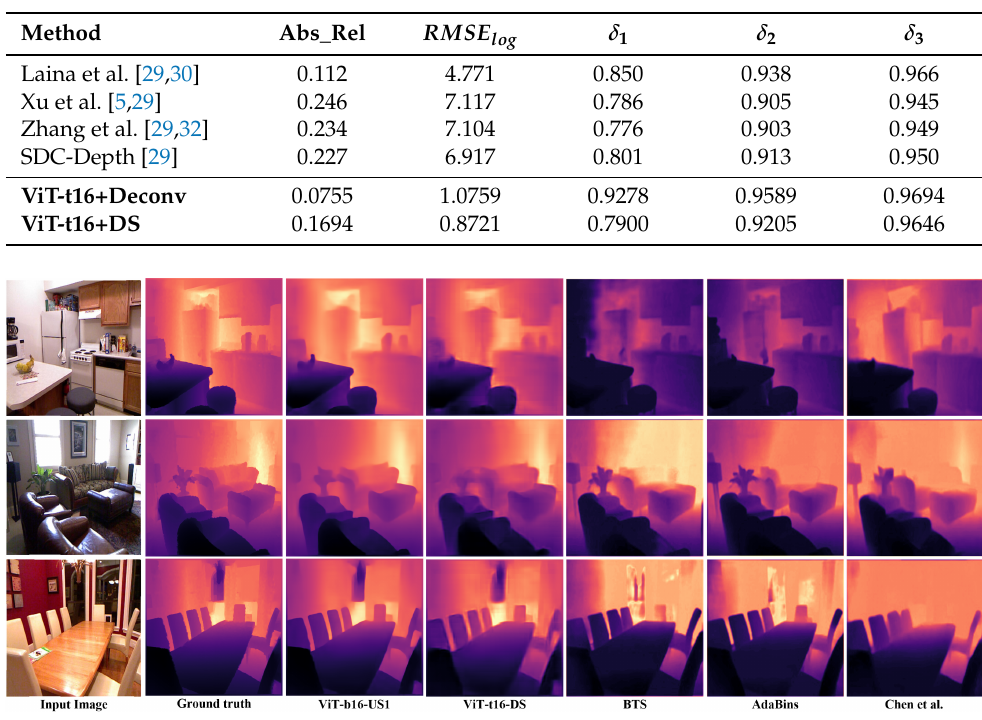
Figure 5. Quality comparison between the depth estimation results obtained by the proposed method (ViT-b16+US1 and ViT-t16+DS), BTS [13], AdaBins [22], and Chen et al. [1] on sample images from the NYU-depthv2